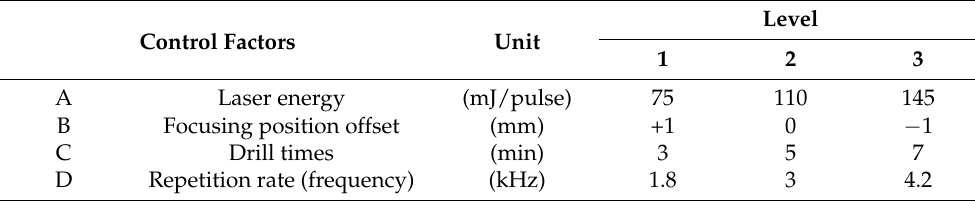
Table 2. Control factors and their levels.